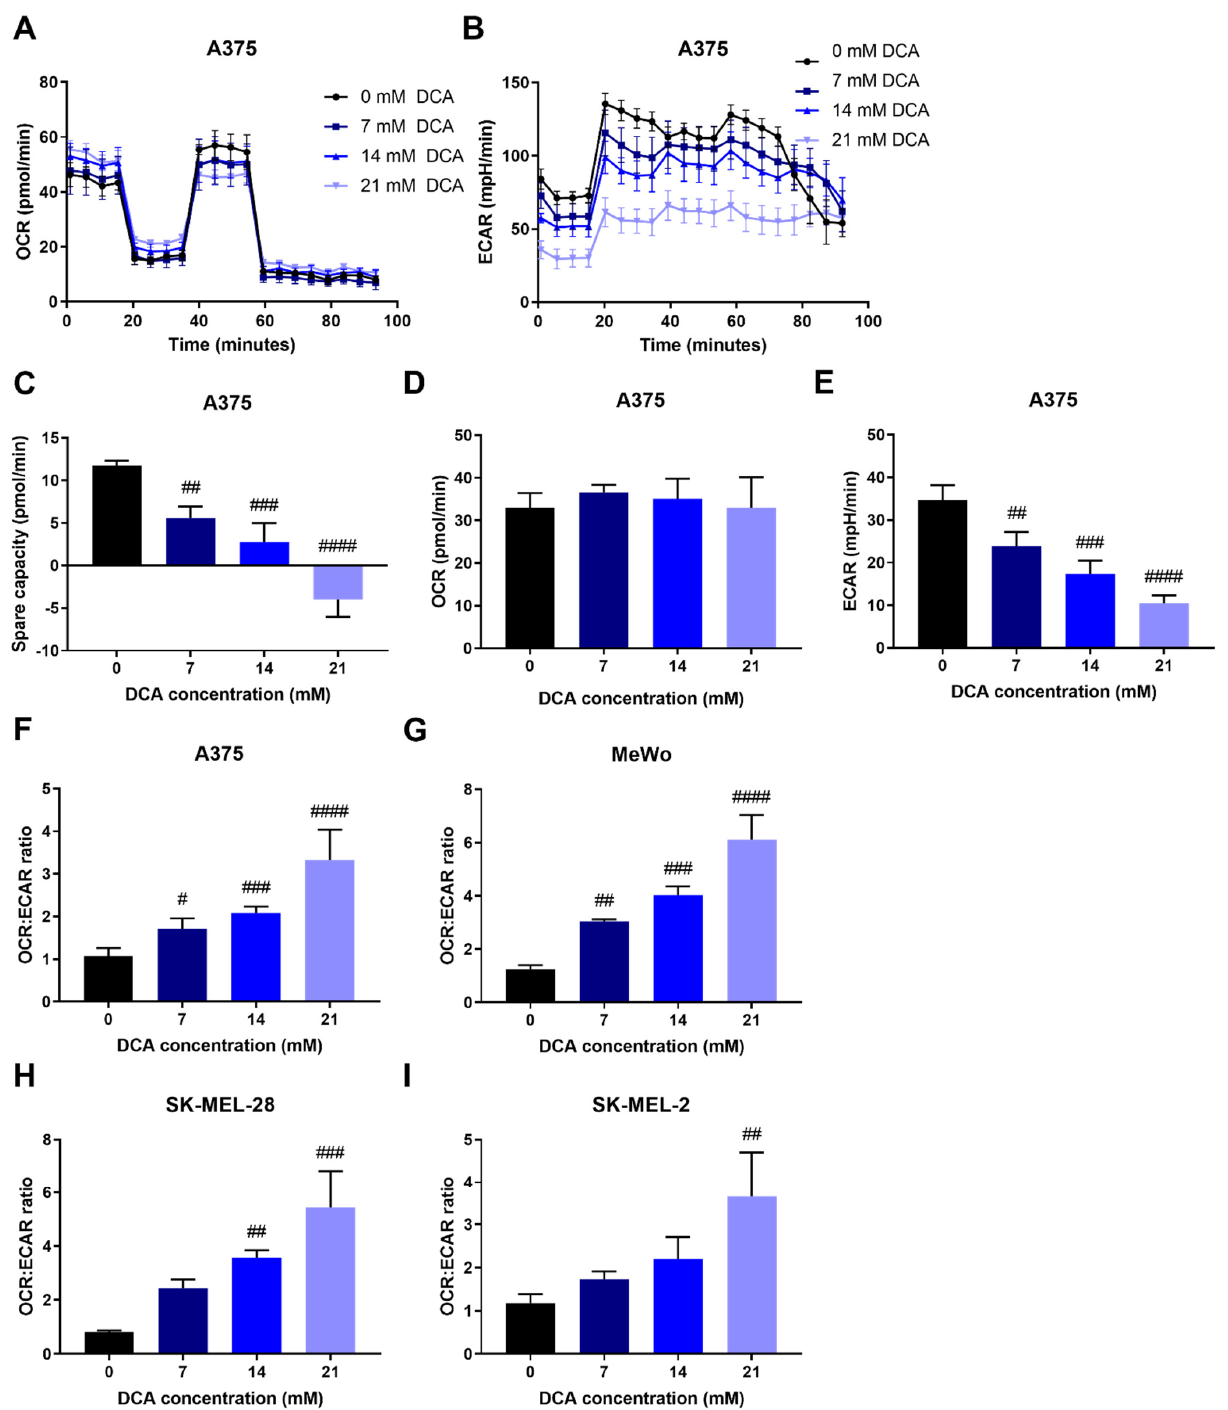
Figure 3. Metabolic adaptation upon PDK inhibition. ( A ) Representative image of OCR in A375 cells measured by Seahorse, mean ± SD of 6–8 technical replicates are shown. ( B ) Representative image of ECAR in A375 cells measured by Seahorse, mean ± SD of 6–8 technical replicates are shown. ( C ) Spare capacity, e.g., maximal OCR minus basal OCR, is decreased by DCA treatment in A375 cells. DCA treatment does not affect ( D ) basal OCR, whereas it dose ‐ dependently decreases ( E ) ECAR in A375 cells. DCA treatment increases the OCR:ECAR ratio in ( F ) A375, ( G ) MeWo, ( H ) SK ‐ MEL ‐ 28 and ( I ) SK ‐ MEL ‐ 2 cells. ( C – I ) Data represent mean ± SD of 3–6 independent experiments, each consisting of 6–8 technical replicates. One ‐ way ANOVA followed by Dunnett’s multiple comparison test, # p < 0.05, ## p < 0.01, ### p < 0.001, #### p < 0.0001, DCA ‐ treated vs. control.